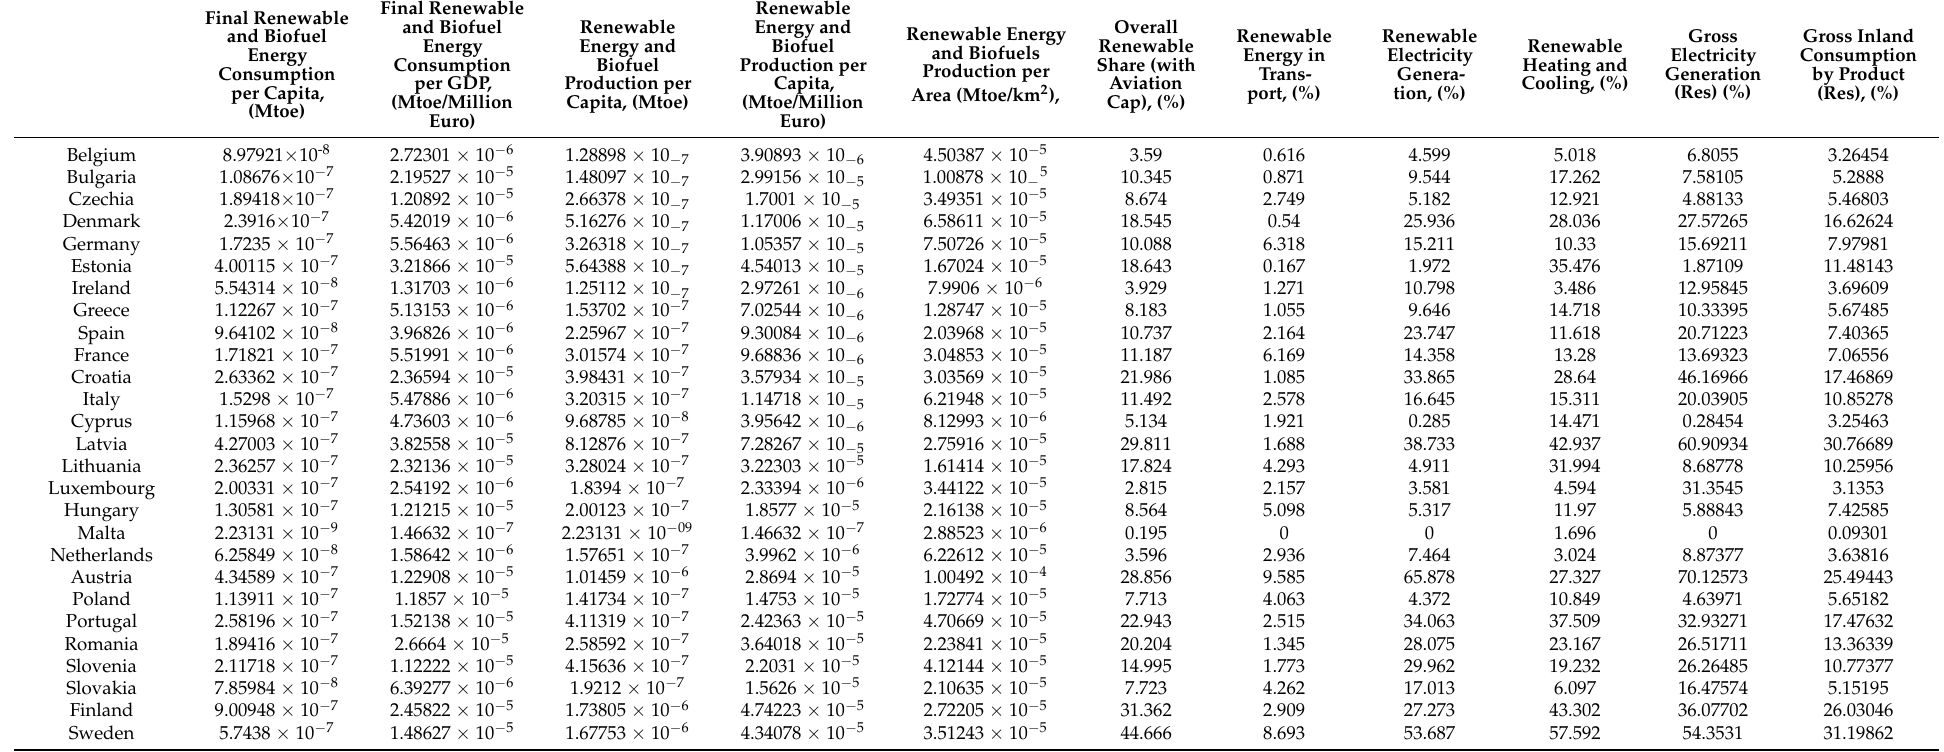
Table A1. Values Renewable energy indicators in 2008 (own elaboration based on